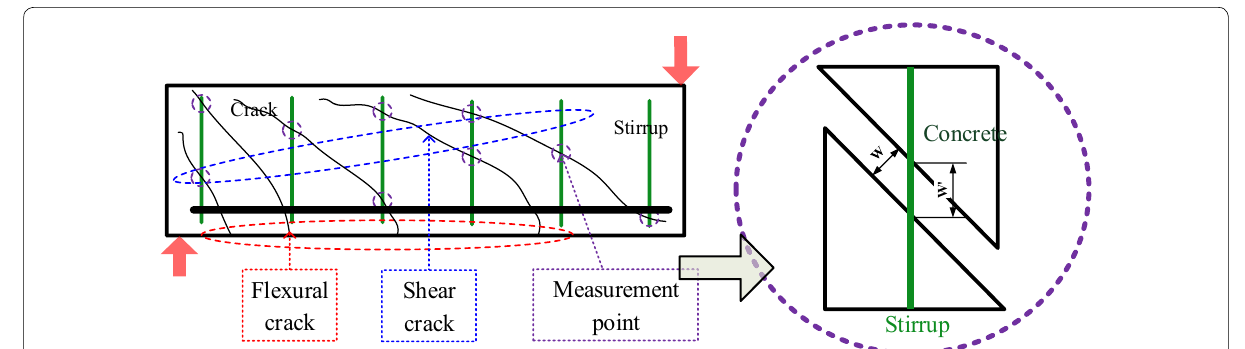
Fig. 6 Measuring cracks of various types at various positions in a